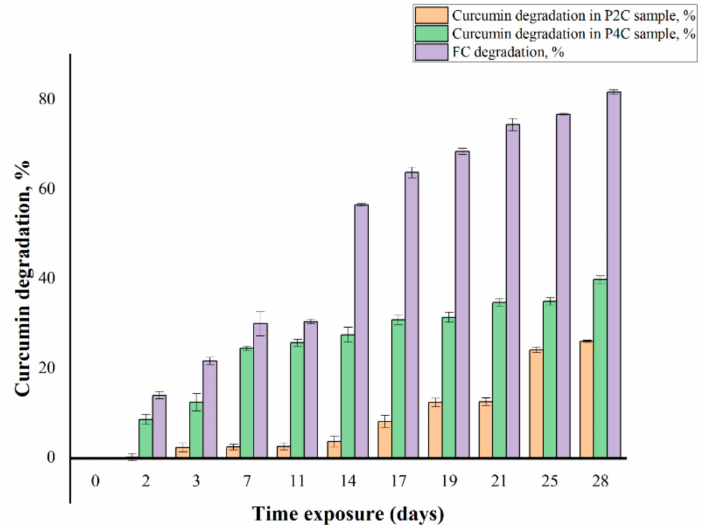
Figure 1. Curcumin degradation (%) of the free curcumin (FC) and the curcumin encapsulated in the P2C and P4C samples. All samples were exposed for 28 days to natural light and air.